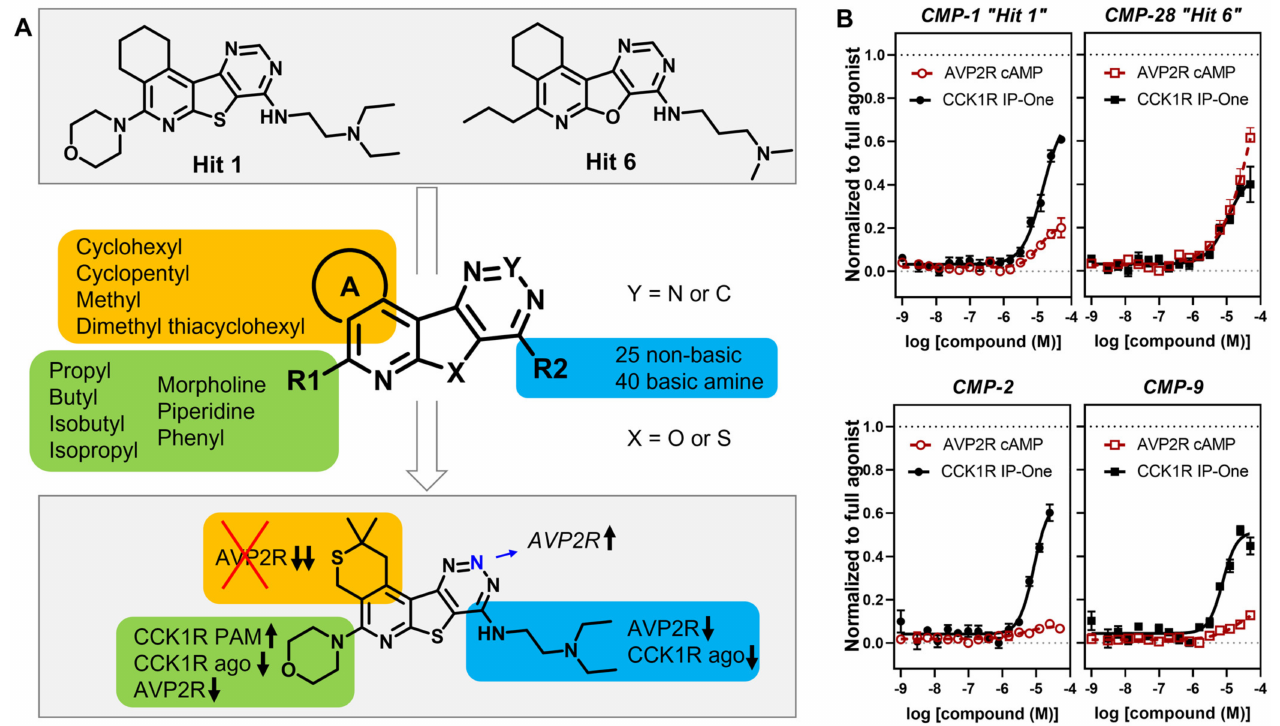
Figure 6. Elucidation of structural determinants impacting the pharmacological profile of tetracyclic analogs ( A ). “Hits” 1 and 6 were subjected to a comprehensive SAR campaign elucidating struc- tural features with distinct effects on CCK1R PAM, CCK1R agonist and AVP2R off-target activity. ( B ) Dose–response curves of “hit 1” and “hit 6” (top) and optimized dimethyl thiacyclohexyl analogs CMP-2 and CMP-9 (bottom) in CCK1R IP-One and AVP2R cAMP assays, both conducted in PAM format. Data are shown in Tables